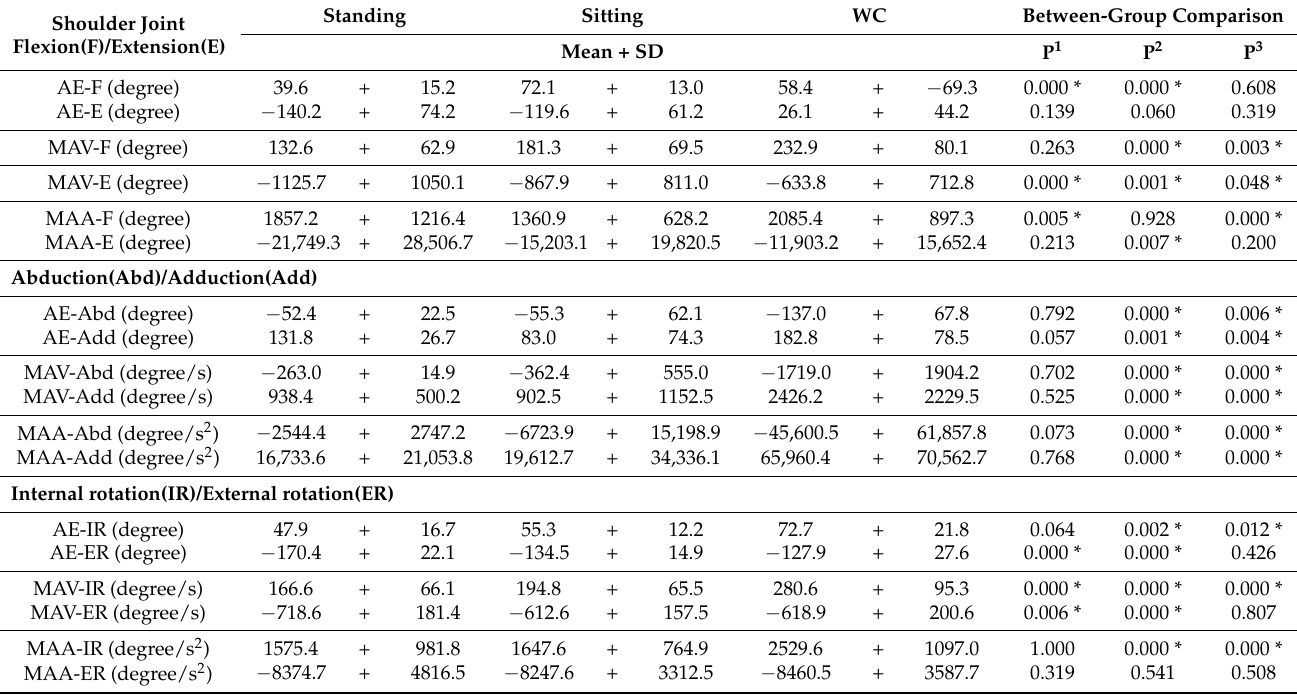
Table 6. Comparison of shoulder joint flexion/extension, abduction/adduction, internal rotation/external rotation angular excursion, maximum angular velocity, and maximum angular acceleration of three